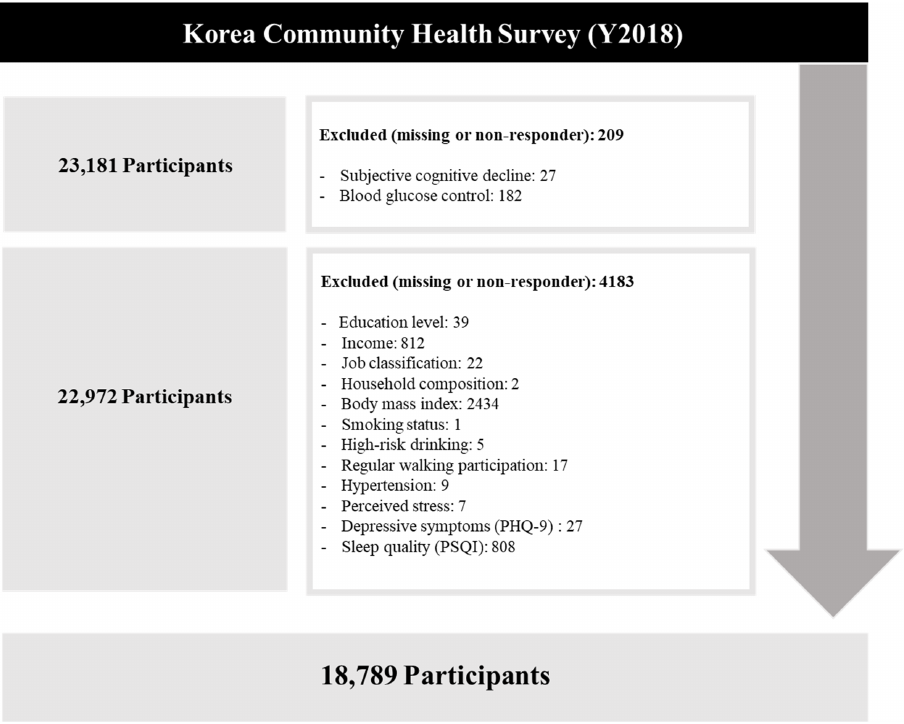
Figure 1. Selection of study participants.